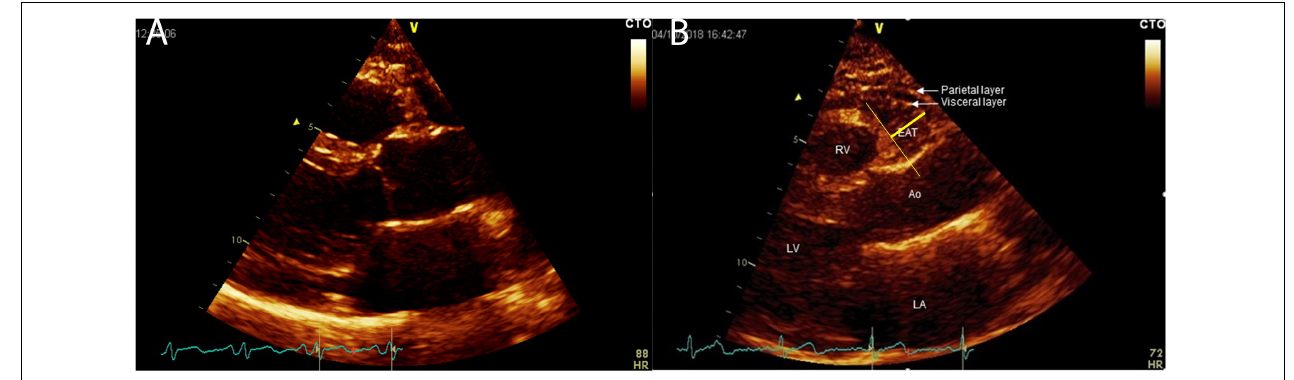
FIGURE 1 | EAT thickness visualization and measurement in parasternal long axis view; panel (A) thin epicardial adipose tissue; panel (B) thick epicardial adipose tissue. EAT, Epicardial Adipose Tissue; LA, left atrium; LV, left ventricle; Ao, ascending aorta; RV, right ventricle. EAT is visualized between the visceral layer of the pericardium an the myocardium at the Rindfleisch fold.